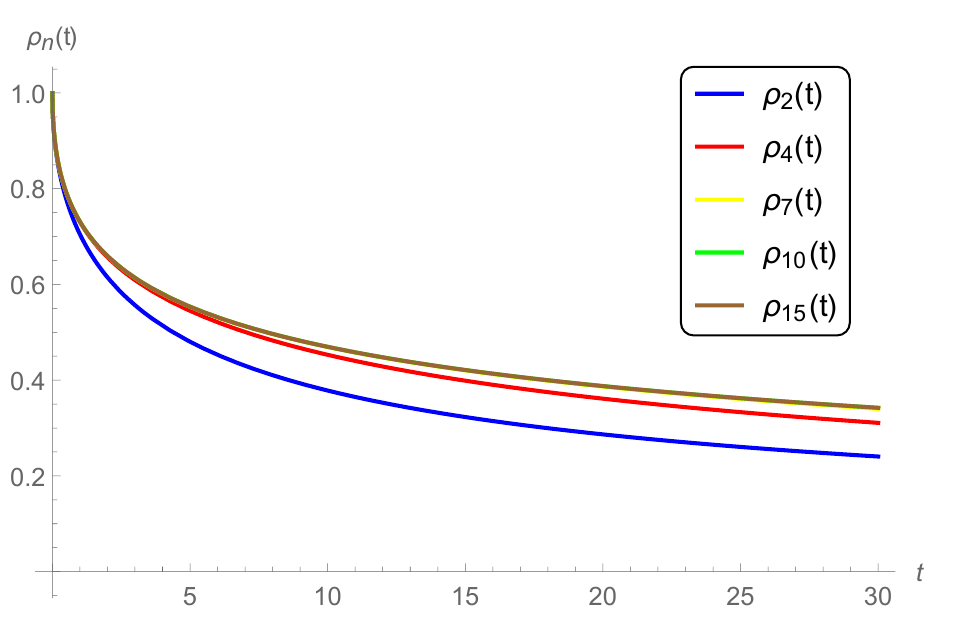
Figure 1. Graphs of the n -th approximate solution of (11), (12) with n = 2,4,7,10,15 and λ = 1, q = 1.5, and α = 0.5. Table 1. The residual error RE 10 ( t ) when λ = 1 and q = 1.5 at three different values of α .